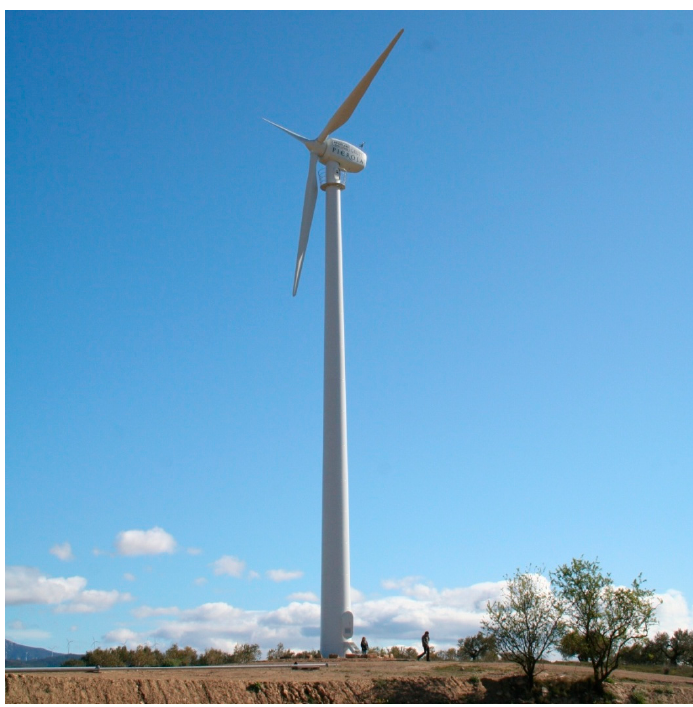
Figure 5. The 100-kW horizontal wind turbine of the Argolabe S.L. Engineering Company.